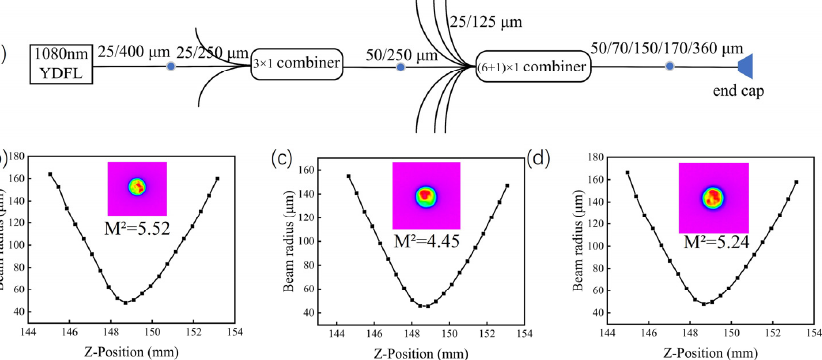
Figure 9. The diagram of cascading of 3×1 fiber signal combiner and (6 + 1) × 1 fiber signal combiner and the beam quality. ( a ) The diagram of testing; ( b ) The beam quality of f1; ( c ) The beam quality of f2; ( d ) The beam quality of f3.